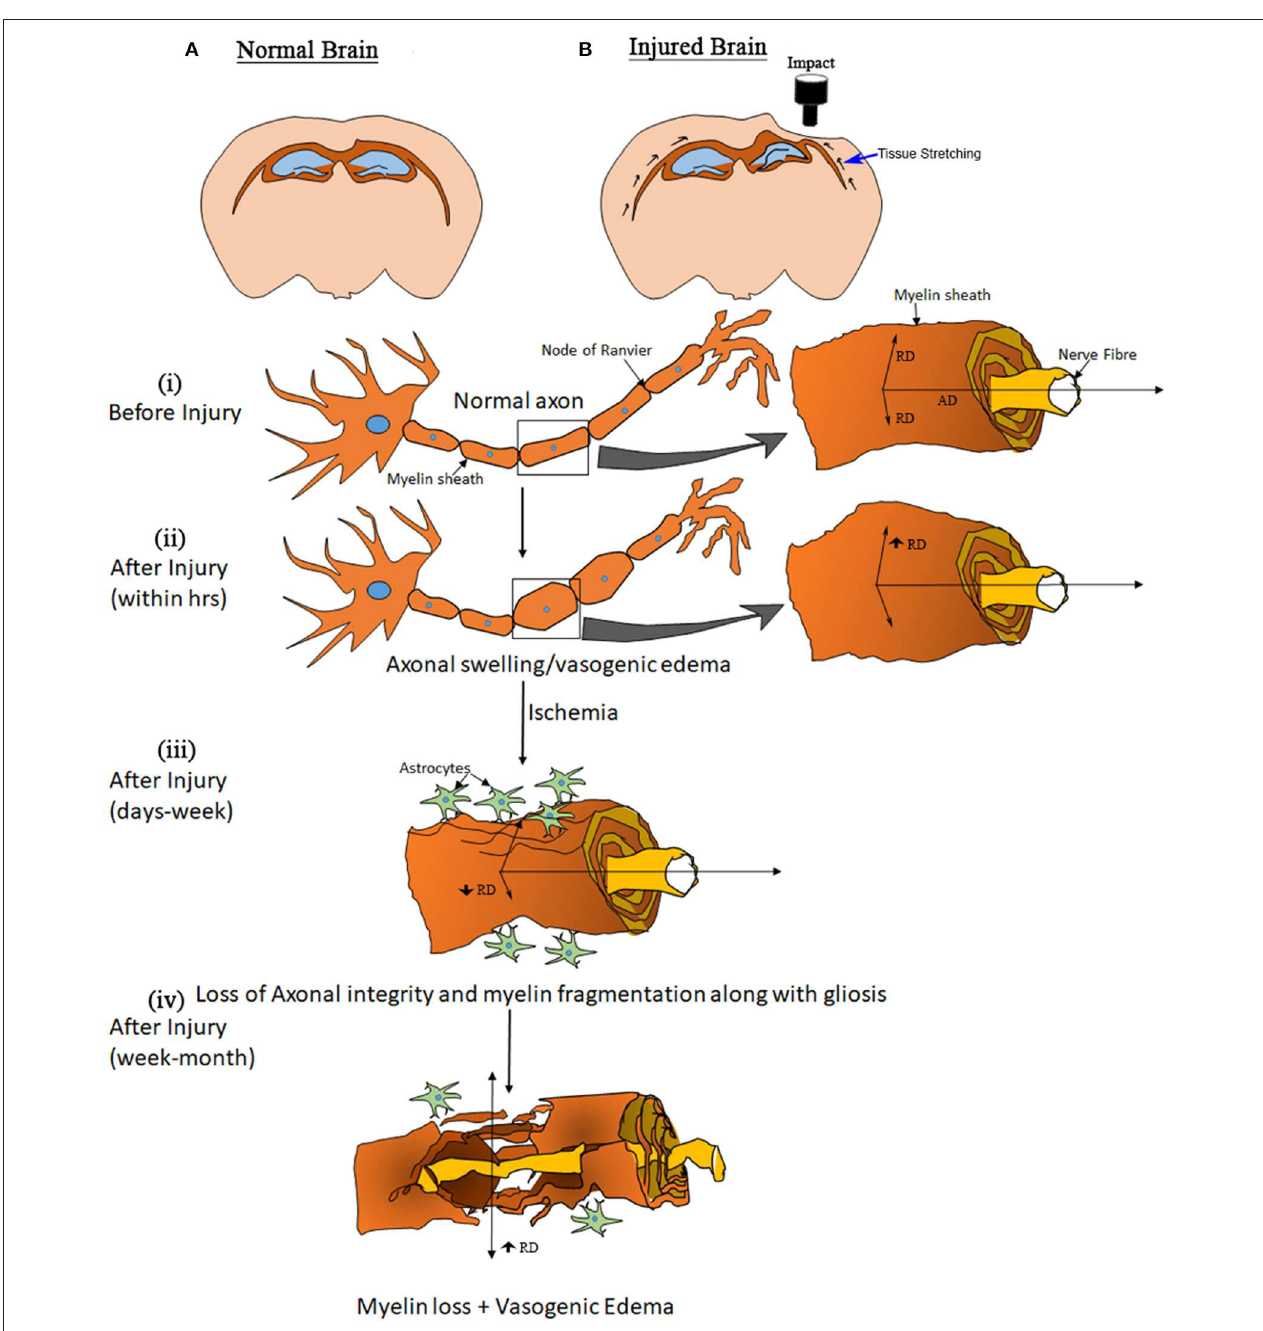
FIGURE 6 | Model of elasticity. Drawings at the top show a normal brain (A) and the likely deformation in an injured brain. (B) Black arrows along the white matter in the injured brain illustrate an expected biomechanical response due to the cortical impact. The other graphics, showing a white matter fiber, elucidate the apparent processes involved after open skull injury to the brain. (B) (i) shows the structure of an axon representing normal myelination along with water diffusion parallel (AxD—axial diffusivity) and perpendicular (RD—radial diffusion) to the direction of fibers. (B) (ii) shows a swollen axon within hours post-injury, and the increased diffusivity (no change in frequency shift and QSM) may be explained by a stretching of the myelin sheath. (B) (iii) represents the condition of an axon within days to weeks after injury. Tissue damage causes changes that can lead to ischemia followed by inflammation, an acute immune response to clear cell debris. During this period the axons start to lose structural integrity and myelin sheath fragmentation and gliosis initiate, observed as a reduction in RD and AxD (increase in frequency shift and QSM) that may lead to myelin loss. (B) (iv), resulting in an eventual increase in RD (increase in QSM).